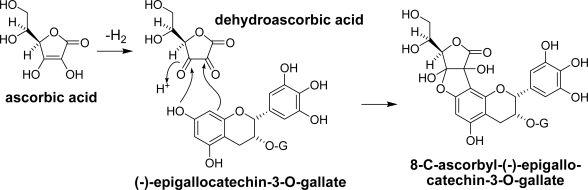
Formation of 8-C-ascorbyl-(−)-epigallocatechin-3-O-gallate [73].